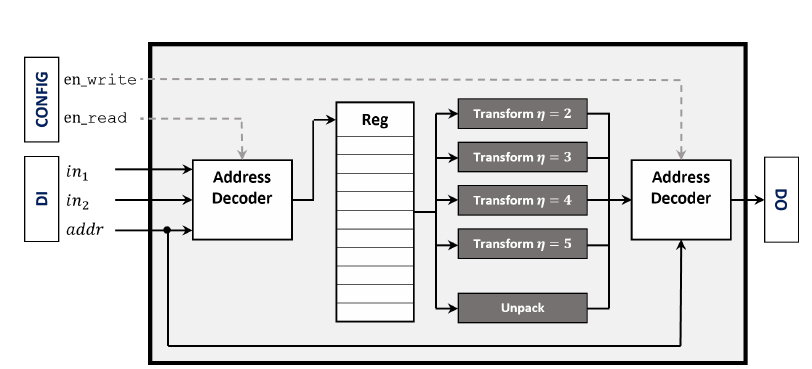
Figure 9: Bit-slicing accelerator. Dashed lines illustrate control